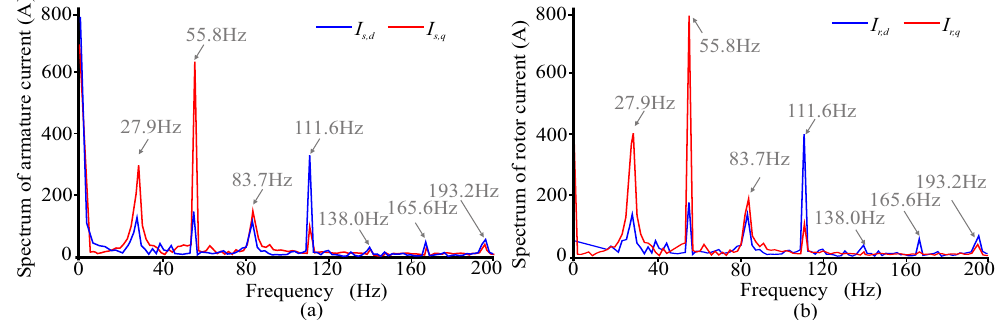
Figure 4. EFR currents frequency spectrum in dq + . ( a ) Armature I + I + (blue) and I + r , q r , d